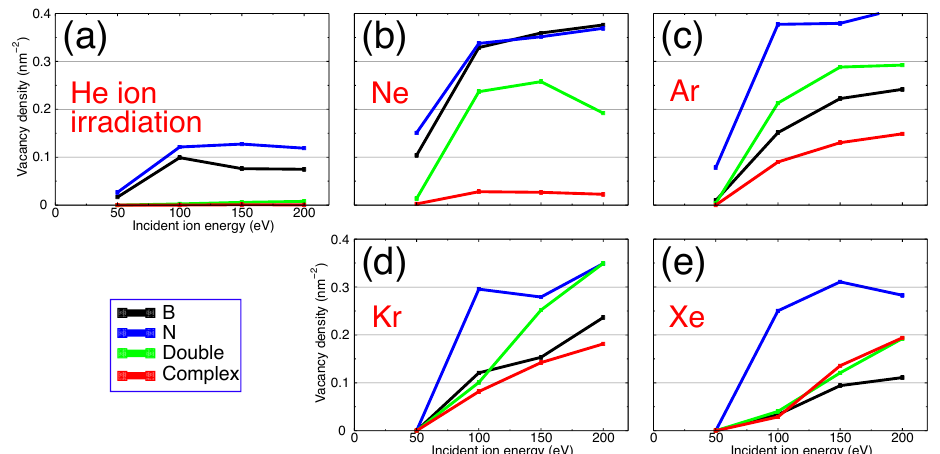
Figure 4. Densities of vacancies in single layer h-BN after irradiation with a fluence of 5 × 10 14 ions/cm 2 as functions of ion energies for various inert gas ions. Panels ( a – e ) show irradiation with He, Ne, Ar, Kr and Xe ions, respectively.